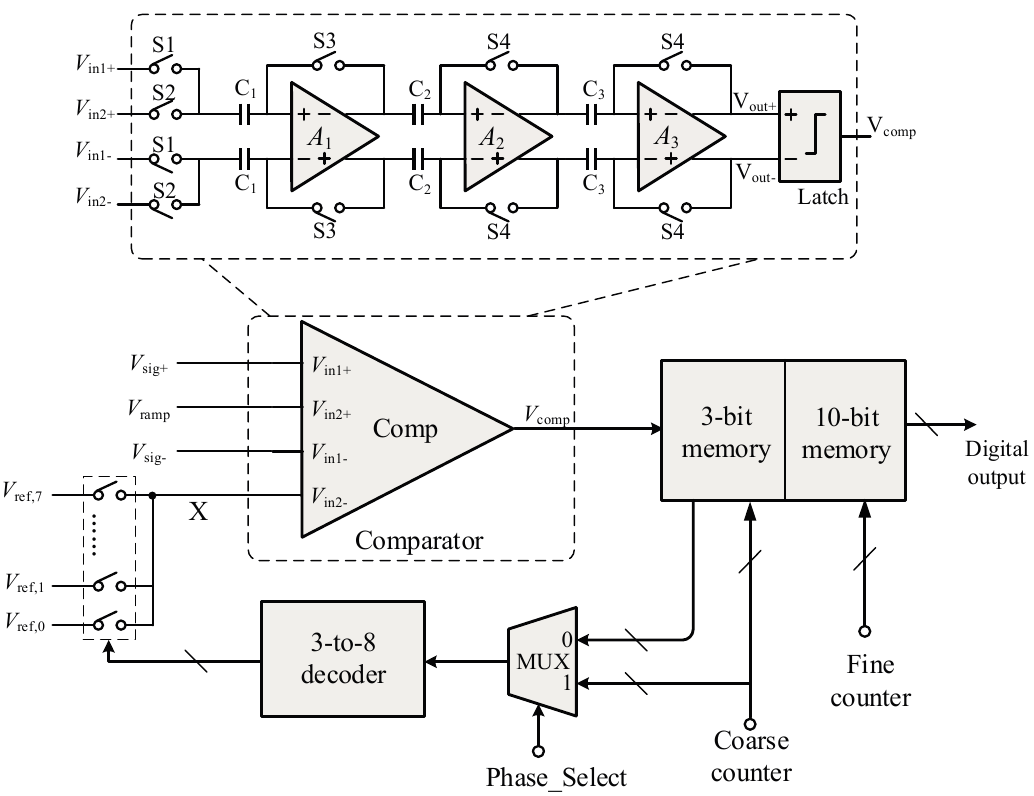
Figure 16. Simplified block diagram of the column